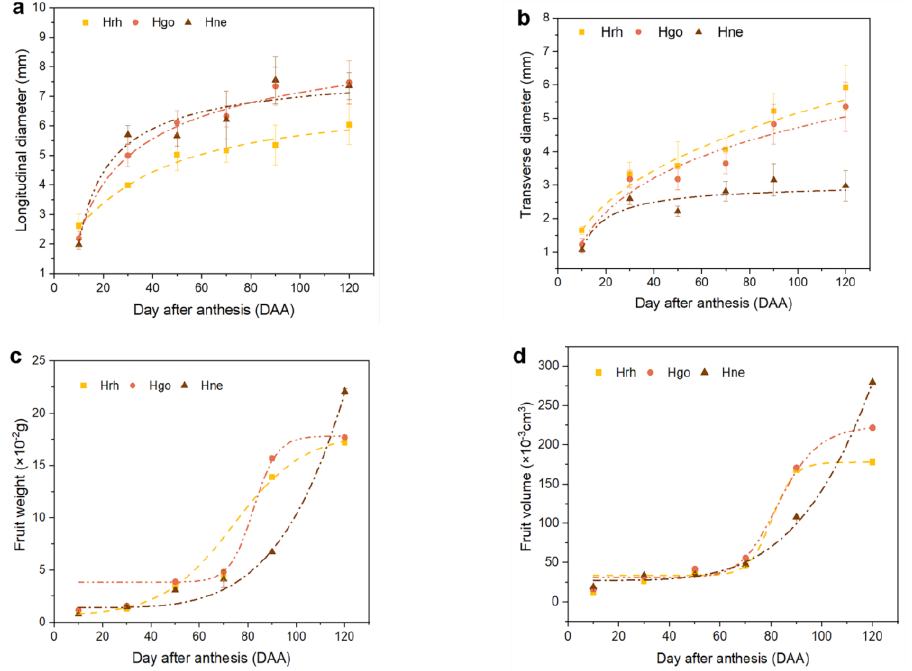
Figure 3. The fruit characteristics of three species of Hippophae. ( a ) Longitudinal diameter; ( b ) Transverse diameter; ( c ) Fruit weight ( d ) Fruit volume. Hrh H. rhamnoides ssp. sinensis ; Hgo H. goniocarpa ; Hne H. neurocarpa. Error bars represent the standard deviation (SD). (n = 50 fruits). Table 1. Logistic models fitted for longitudinal diameter, transverse diameter, fruit weight and volume against 10 until 120 DAA of three species of Hippophae fruit according to R 2 .